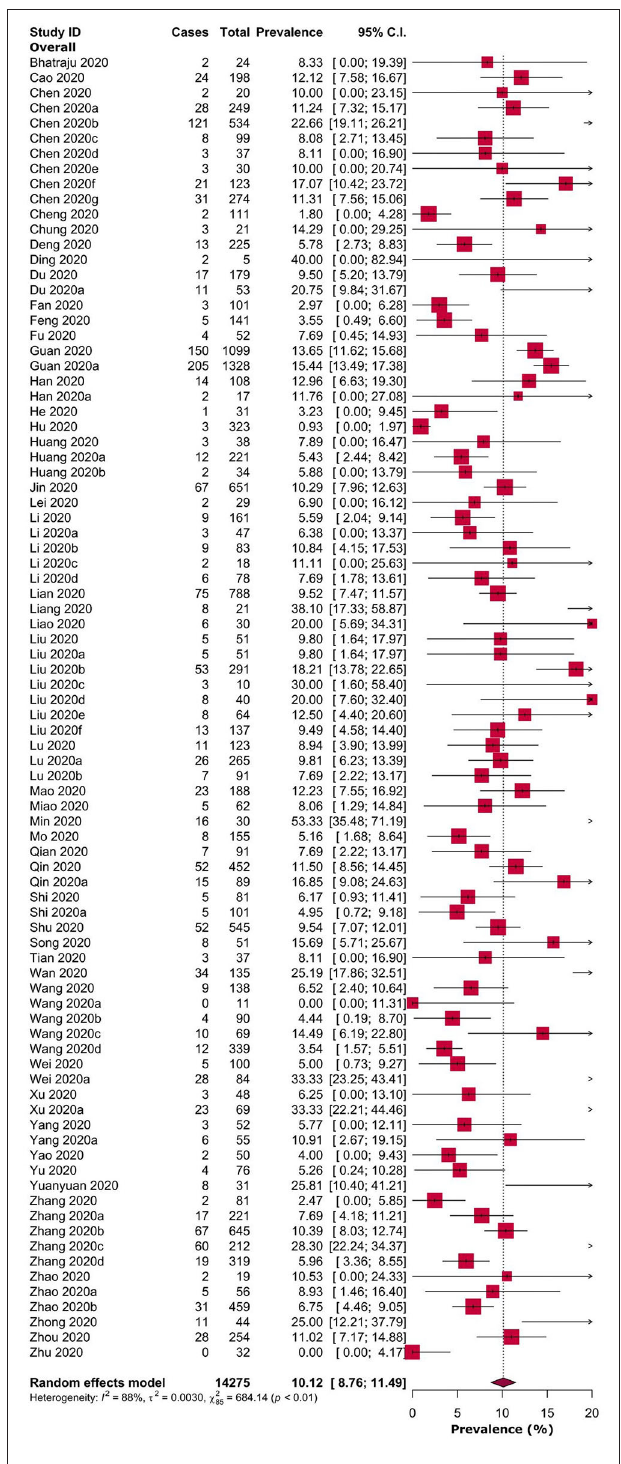
FIGURE 2 | Prevalence of headache in adult COVID-19